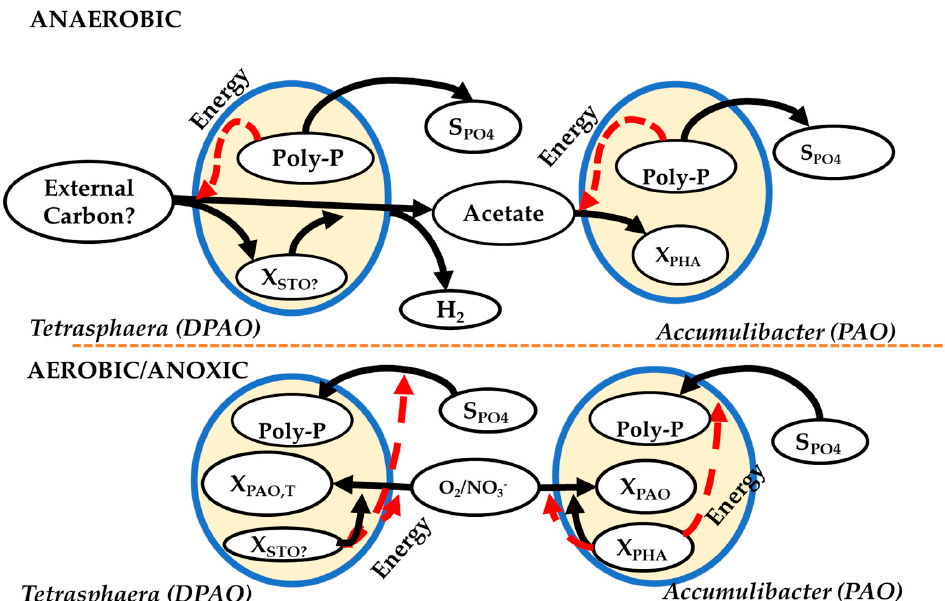
Figure 2. Comparison of the metabolic pathways and biochemical transformation of P between Tetrasphaera and Ca. Accumulibacter in full-scale EBPR. S PO4 —external phosphate, X PHA —internal polyhydroxyalkanoates, X PAO —biomass of the PAO, X STO?— not yet characterized internal carbon storage material, X PAO, T —biomass of Tetrasphaera . Adapted from Makinia and Zaborowska